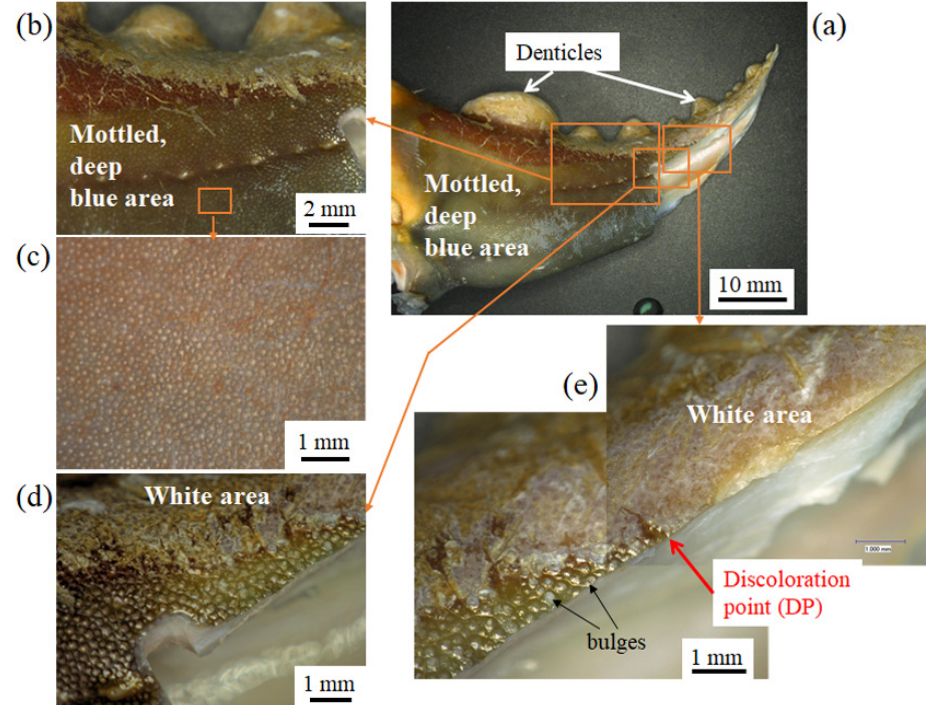
Figure 3. ( a ) Digital micrographs showing the surface of the movable finger of a mud crab’s claw observed through a digital microscope (VHX-900, Keyence Corporation, Osaka, Japan). Enlarged images of the area enclosed by the rectangles in ( a ): ( b ) the mottled, deep-blue area, ( d ) the area between the blue and white areas, and ( e ) the DP area. ( c ) Enlarged image of the area enclosed by the rectangles in ( b ). Many bulges of various sizes were observed on the surface of the blue area. Here, the fingertip was broken by hitting the back of a chisel with a hammer to prepare a test piece for fracture-surface observation.